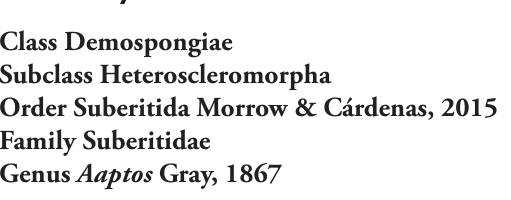
Material examined. Holotype: MSNG 60134, PH-1, 13/01/2005, Timur (Bunaken Island), about 20 m depth. Paratype: MSNG 60135, PH-27, 13/01/2005, same local- ity as holotype, about 20 m